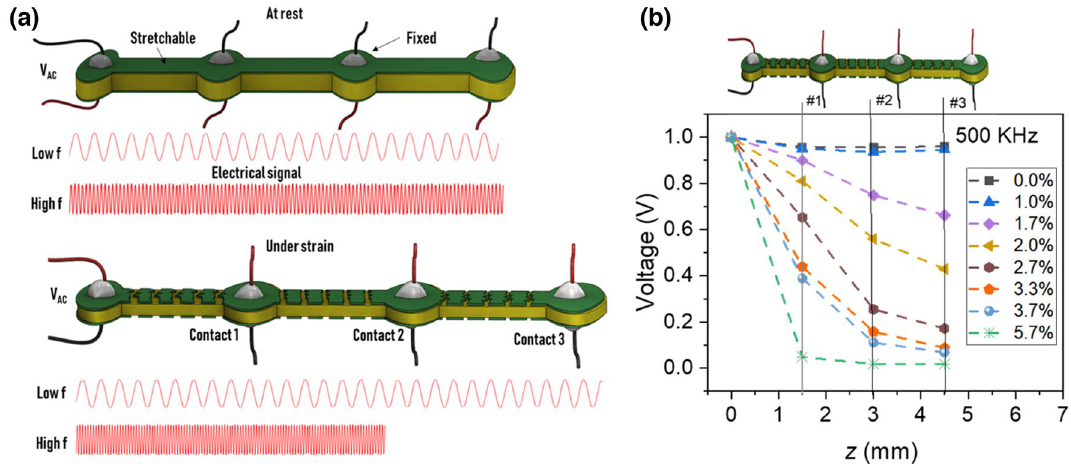
Figure 2. ( a ) Schematic of voltage dissipation through the non-cracked and cracked structure at low and high signal frequencies; ( b ) experimentally determined voltage dissipations along the sensor length (z-direction) under different external strains.